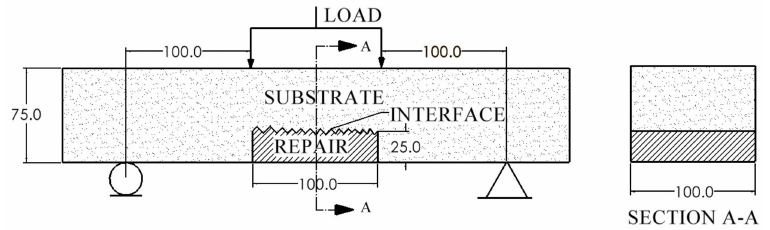
Figure 2. Prismatic specimens under four-point loading (all dimensions are in